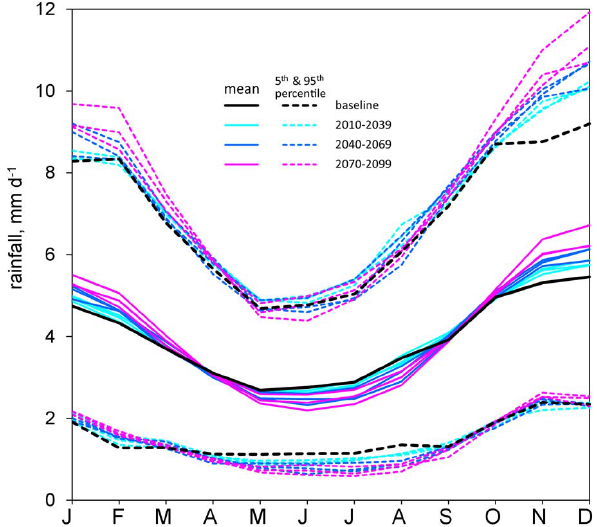
Fig. 6. Mean daily precipitation and 5th and 95th percentiles from the 100 30-yr simulations for the Low, Medium, and High emissions scenarios and three time periods 2010–2029 (in cyan), 2040–2069 (in dark blue), 2070–2099 (in pink), and baseline (in black).